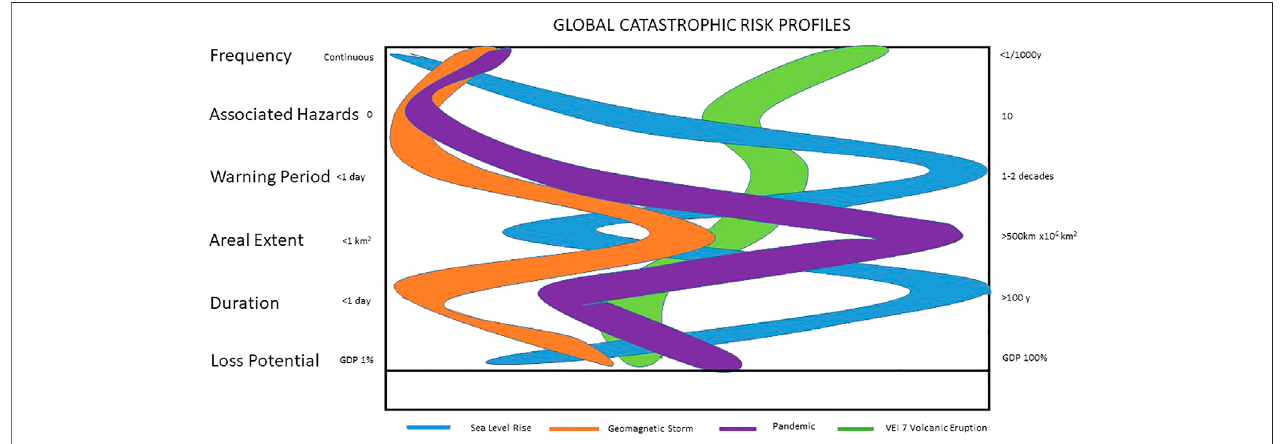
FIGURE 2 | Global Catastrophic Event Pro fi les based on selected physical characteristics. Expected values are indicative rather than